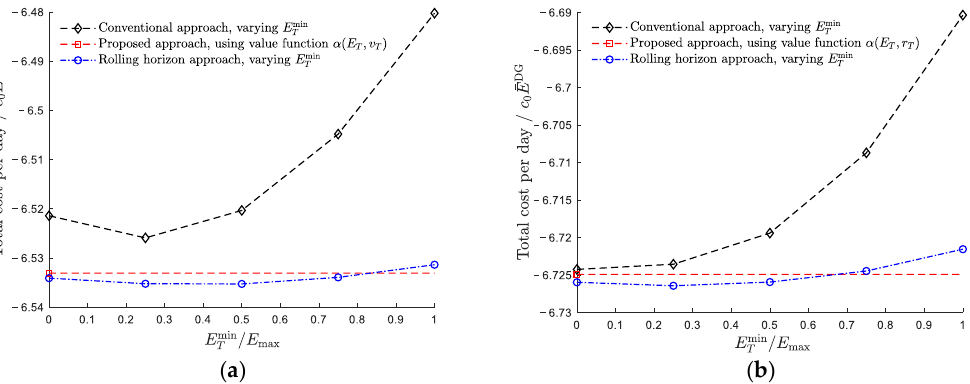
Figure 7. Comparison of approaches to considering the expected value of stored energy at the end of the planning horizon for distributed wind power ( a ) and PV ( b ) generation in terms of the total cost of the distribution system over the simulation period.